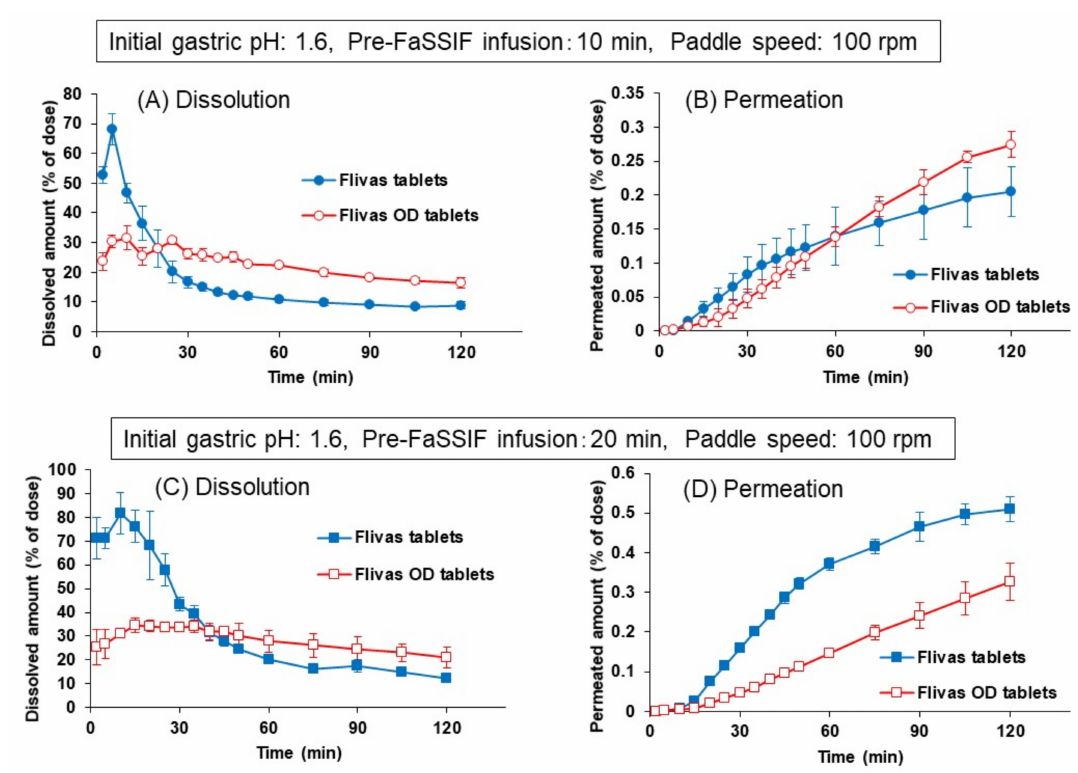
Figure 8. Comparison of dissolution ( A , C ) and permeation ( B , D ) of naftopidil from Flivas ® tablets and Flivas ® OD tablets in the BE checker. Pre-FaSSIF infusion time was set to 10 min ( A , B ) and to 20 min ( C , D ). Initial FaSSGF pH was 1.6, and paddle speed was 100 rpm. Each data point represents mean ± S.D. ( n = 3).